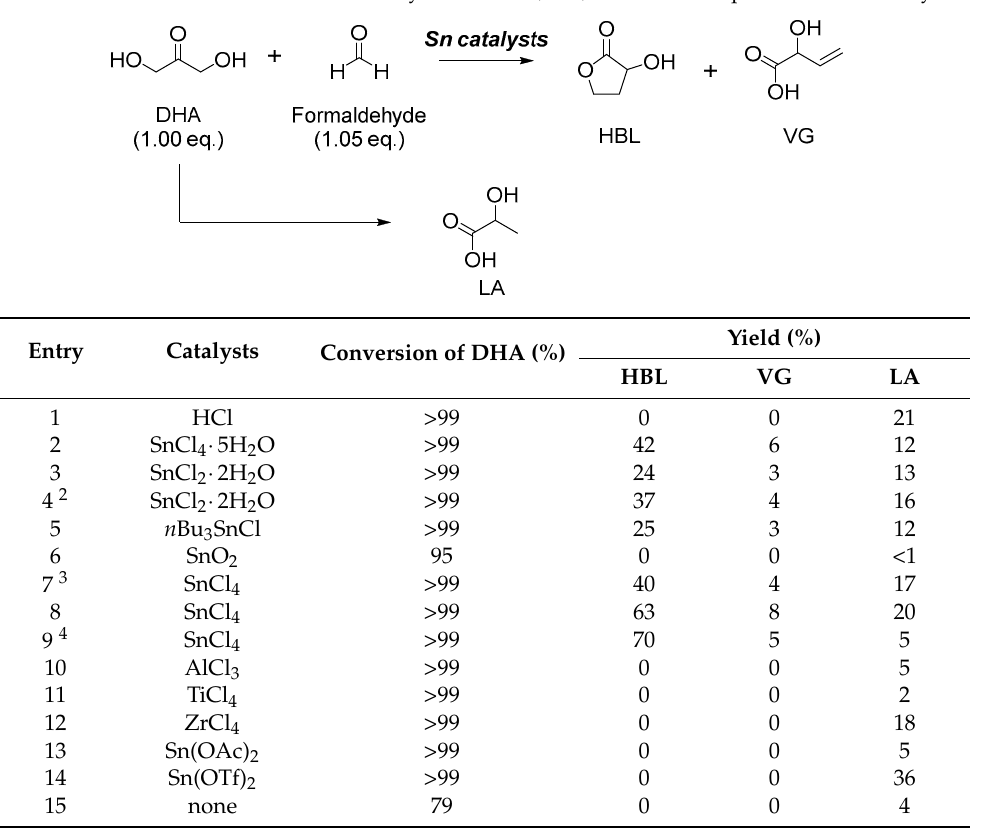
Table 3. Conversion of DHA and formaldehyde into HBL, VG, and LA in the presence of Sn catalysts 1